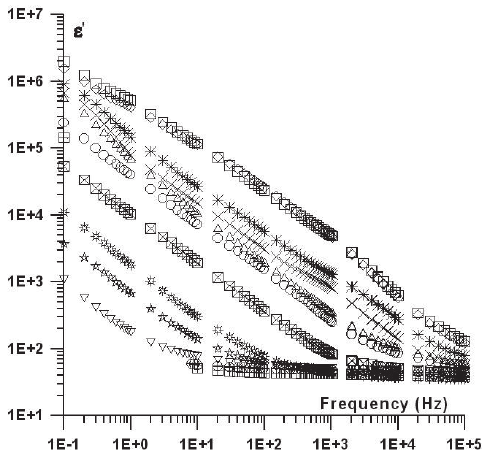
Fig. 1. The variation of the dielectric constant with frequency at different levels of relative saturations (in volume). 4% 0, 8% 0, 11% 0, 14% 0, 18% 0, 25% 0, 32% 0, 40% 0, 50% 0, 55% 0, 96% 0, 100% 0, respectively. There are many symbols that are not present.